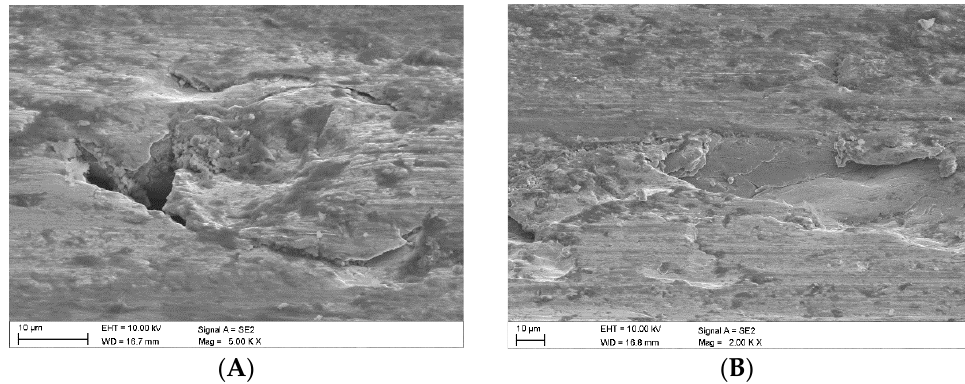
Figure 16. Images of the surface of the steel samples worn in the presence of the Claystone_5 abrasive; ( A )—surface cracks penetrating deep into the surface layer, ( B )—flat surface chipping.